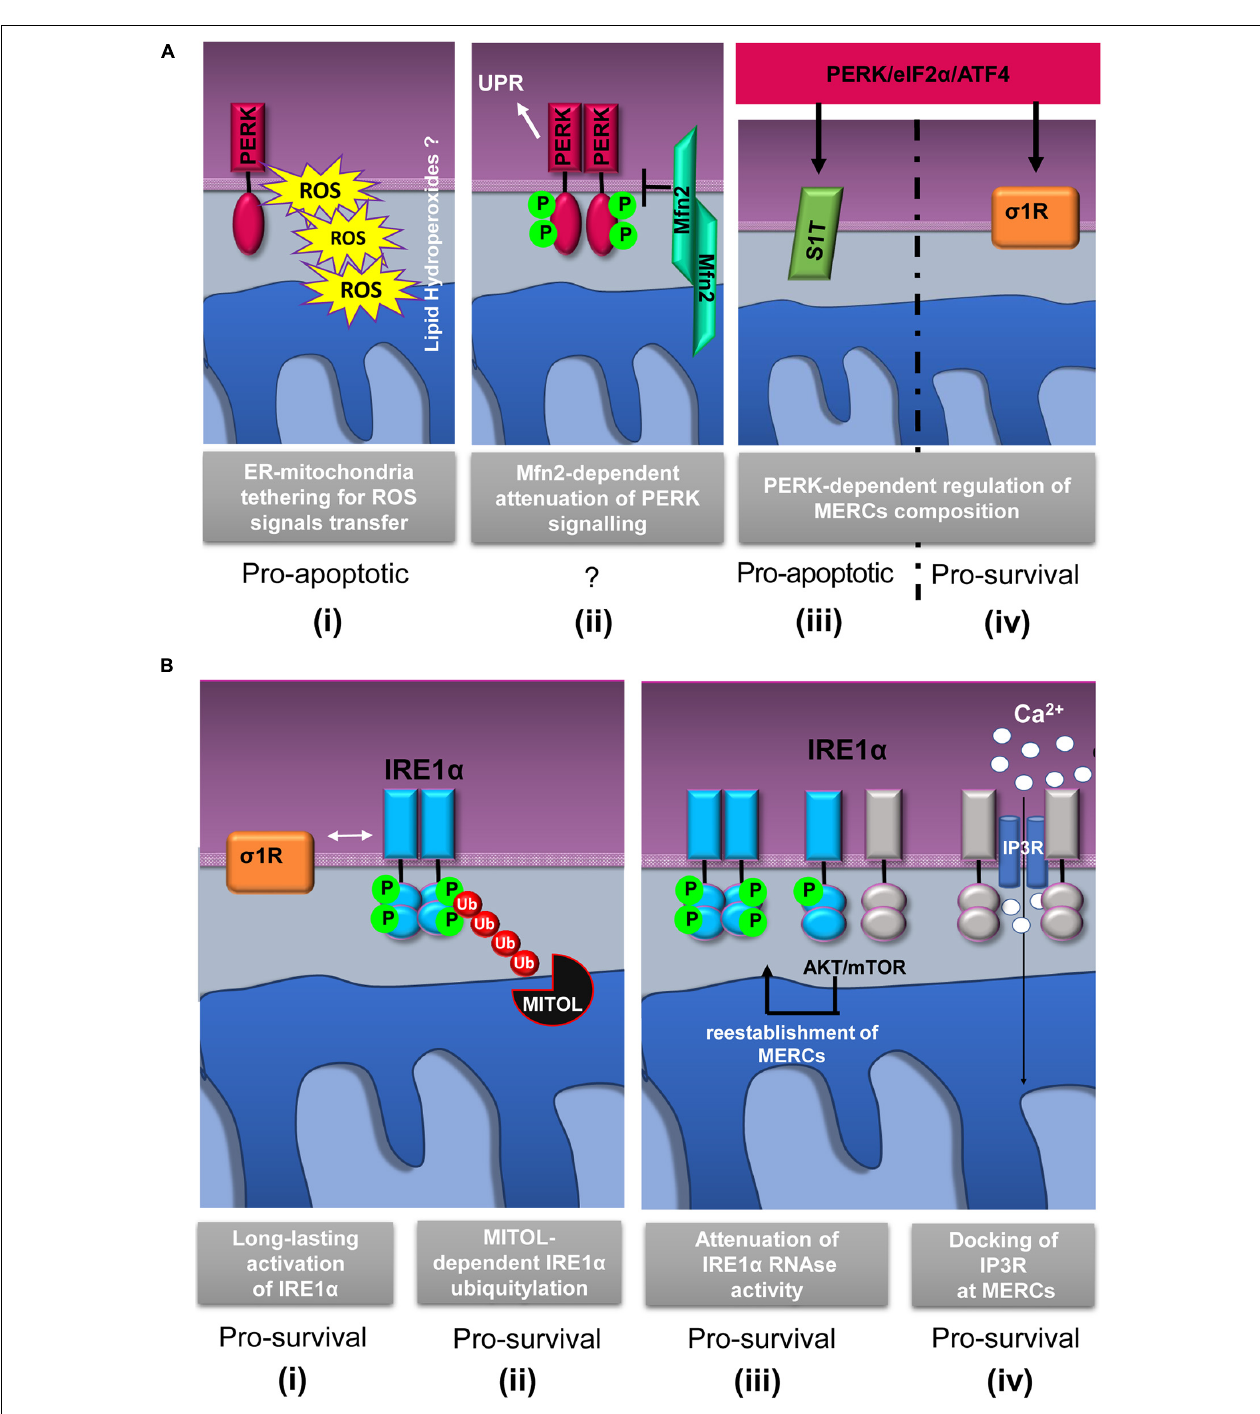
FIGURE 2 | Schematic representation of relevant events involving IRE1 α and PERK proteins at mitochondria–ER contacts (MERCs). (A) PERK-involving events at MERCs: (i) PERK tethers the ER to mitochondria promoting the rapid transfer of reactive oxygen species (ROS) signals, likely under the form of lipid hydroperoxides (Verfaillie et al., 2012); (ii) Mitofusin 2 (Mfn2) lies upstream of PERK and under basal conditions maintains PERK inactive (Munoz et al., 2013); the PERK/eIF2 α /ATF4 signaling pathway upregulates the expression of SERCA1 truncated proteins (S1T) (iii) and sigma-1 receptor ( σ 1R) (iv) at MERCs (Chami et al., 2008; Mitsuda et al., 2011). (B) Events involving IRE1 α at MERCs: (i) σ 1R-dependent stabilization of IRE1 α oligomerization at MERCs (Mori et al., 2013); (ii) mitochondrial ubiquitin ligase (MITOL)-dependent ubiquitylation of IRE1 α at MERCs prevents ER stress induced apoptosis (Takeda et al., 2019); (iii) the AKT-mammalian target of rapamycin (mTOR) signaling attenuates IRE1 RNase activity by promoting the re-establishment of ER-mitochondria contacts (Sanchez-Alvarez et al., 2017); (iv) IRE1 α scaffolds